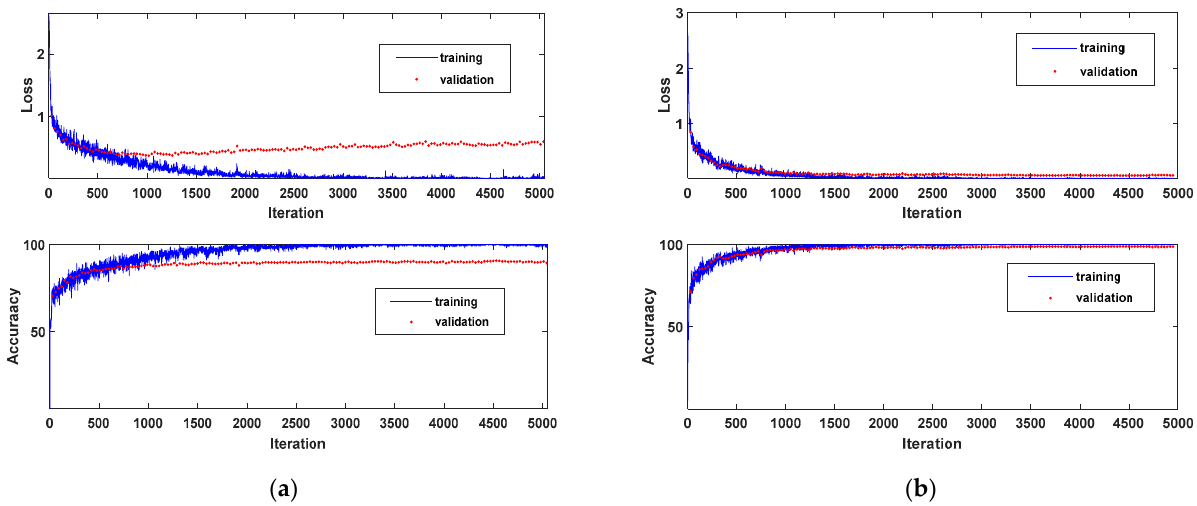
Figure 9. Training curves with the sample size of ( a ) 15 × 15, ( b ) 35 × 35. Table 7. The classification performance of MSCDN with different sample size.